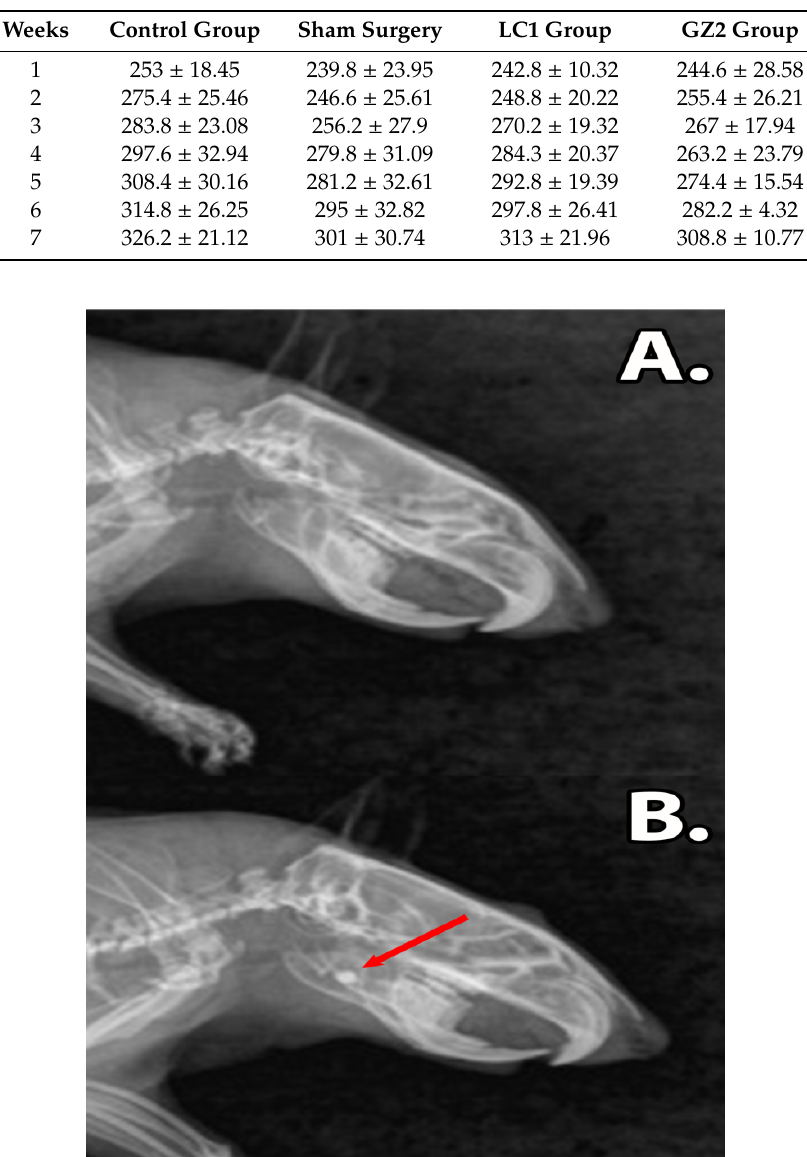
Figure 4. The X-ray images of the rat mandibles, ( A ) sham surgery group. The untreated defect is too small to be clearly observed. ( B ) Group filled with dental restoration material. The composites are clearly differentiated due to the radio opaque properties of the material (red